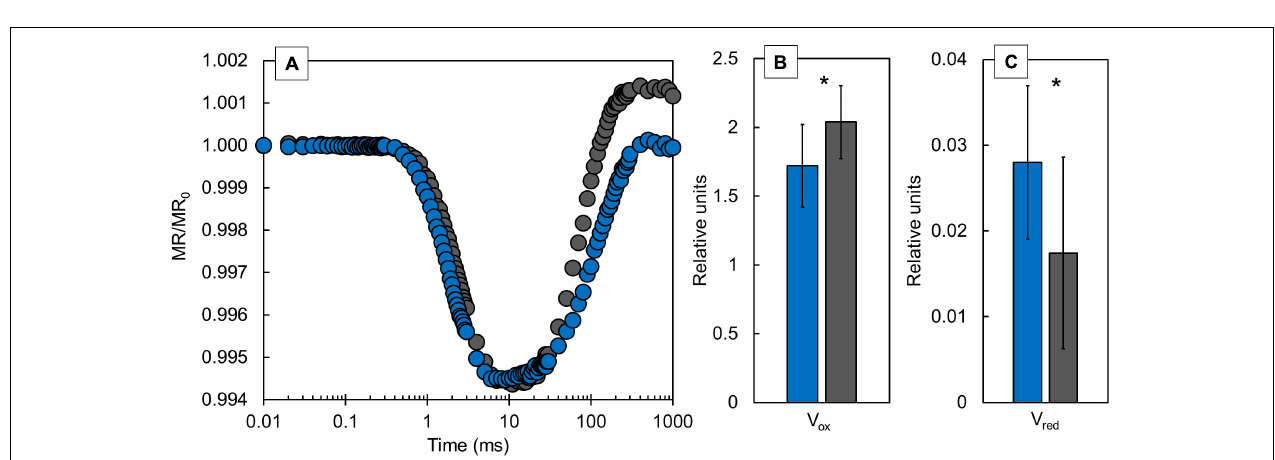
FIGURE 4 | The kinetics of modulated 820 nm reflection (MR) normalized to MR 0 (A) , values of the oxidation rate of PC and P700 [V ox (B) ], and re-reduction rate of PC + and P700 + [V red (C) ] were measured in the Japanese knotweed ( Reynoutria japonica Houtt.) leaves exposed to constant low light (blue) and fluctuating light (gray). The represented values are the mean of 15 replicates per treatment. The asterisk (*) represents a significant difference at p ≤ 0.05 (using the Student’s t -test); error bars represent ± SD.